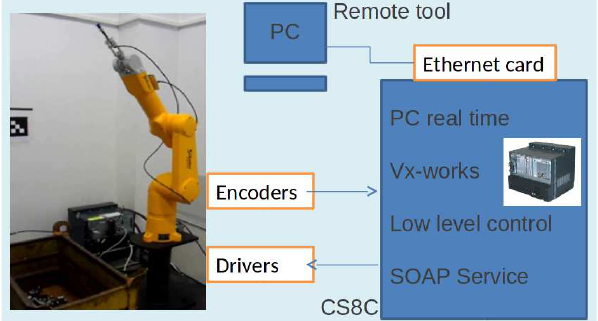
Figure 2. Configuration used on the real robot Stäubli TX 60 L (Stäubli AG, Horgen, Switzerland) and its controller